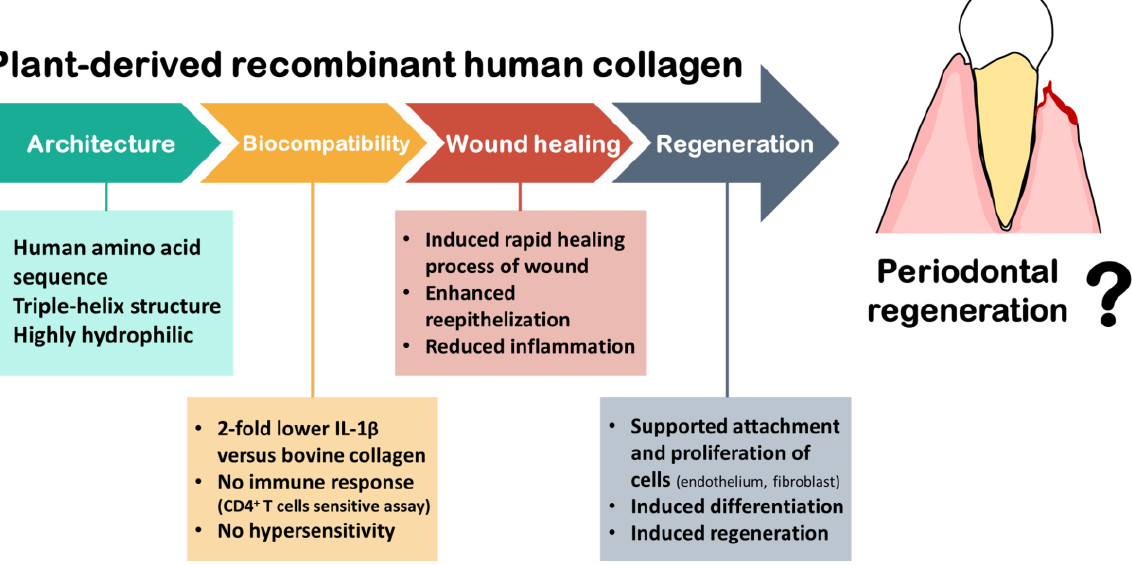
Figure 3 . Chemical and biological properties of plant - derived recombinant human collagen and its Figure 3. Chemical and biological properties of plant-derived recombinant human collagen and its perspectives in periodontal regeneration . perspectives in periodontal